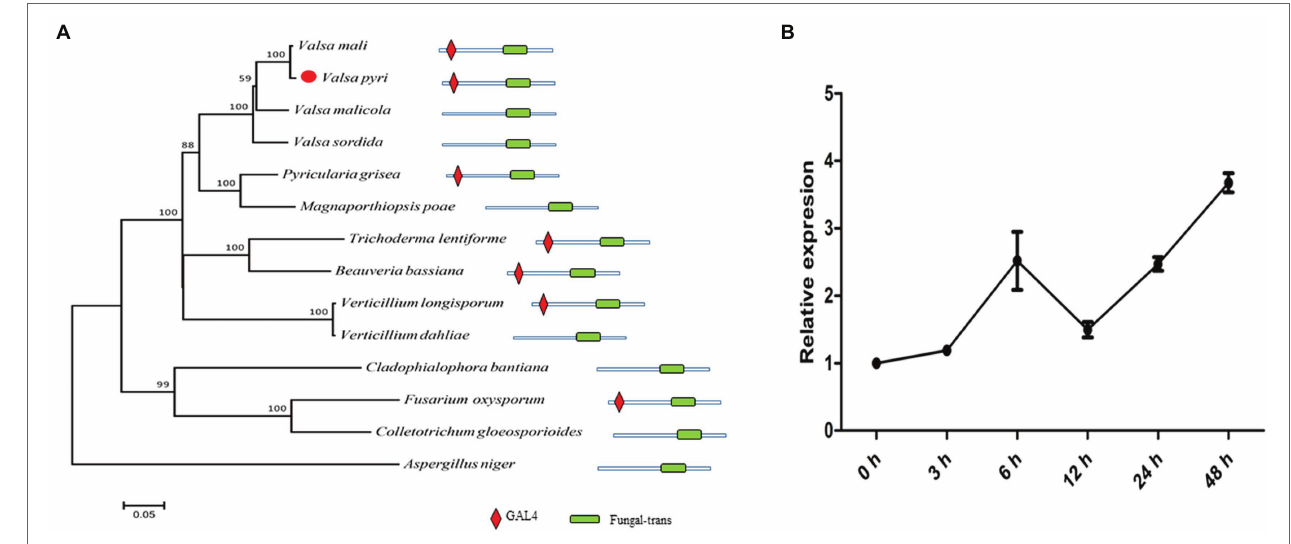
FIGURE 1 | VpxlnR characterization and its expression pattern during infection. (A) Phylogenetic tree of xlnR orthologues in different fungi. The VpxlnR gene sequence was obtained from Valsa pyri transcriptomics data, and sequences of xlnR orthologues were downloaded from the NCBI database. Sequence alignment was carried out using ClustalW, and a phylogenetic tree was generated via the neighbor-joining method using MEGA 7.0 software. The confidence values above the nodes were acquired from 1,000 bootstrap analyses. The domain architecture of VpxlnR and its orthologues were searched with the Pfam database. The domains were manually drawn according to the search results. (B) Transcript levels of VpxlnR during V. pyri infection. The relative expression levels of Vpxl nR in V. pyri were quantified by quantitative reverse transcription PCR (RT–qPCR) and normalized to the transcript levels of the V. pyri actin gene. Fold changes were calculated by the 2 - ∆∆ Ct approach. Each experiment was performed three